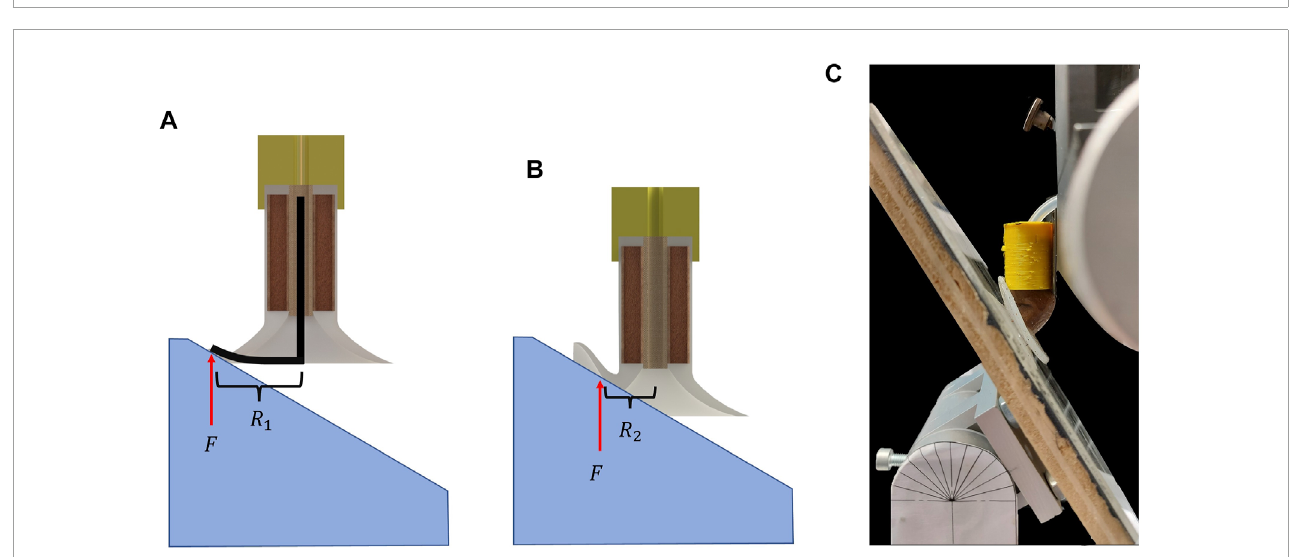
FIGURE 9 (A) Deformation of suction cup with Dragonskin pad which keep the moment arm ( R 1 ) enough for bending the stalk. (B) Deformation of the suction cup with Ecoflex 00–10 suction pad, with shorter moment arm ( R 2 ) due to flexibility of the pad. (C) The adaptation of suction cup with Ecoflex suction pad which deformed irregularly compare to Dragonskin